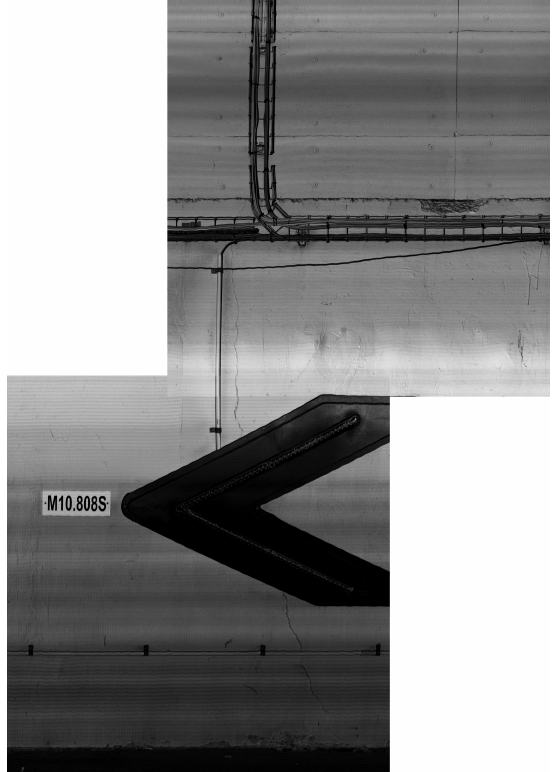
Figure 11. Image stitching (intensity) using two successive strips. A vertical crack is visible on either side of the signalling arrow, and a spall can be seen above the cable